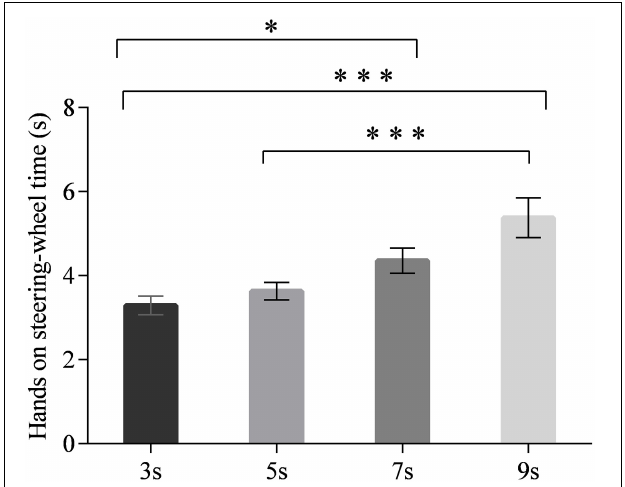
FIGURE 2 | Hands on steering-wheel time for different time intervals. (Notes. * p < 0.05, *** p < 0.001).